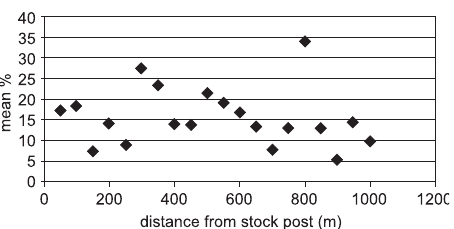
1. Mean percentage deadwood per tree in relation to distance from stockpost ( n = 12 transects).